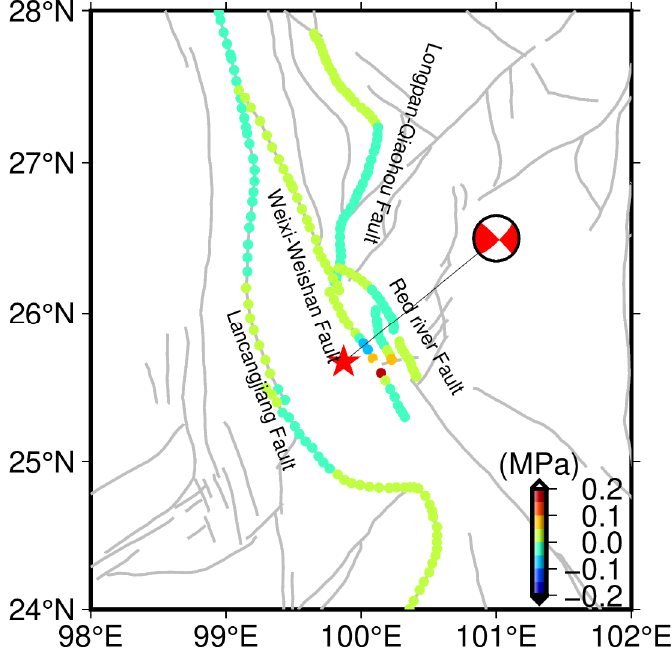
Figure 10. The static Coulomb stress changes of surrounding large faults caused by the Yangbi earthquake.